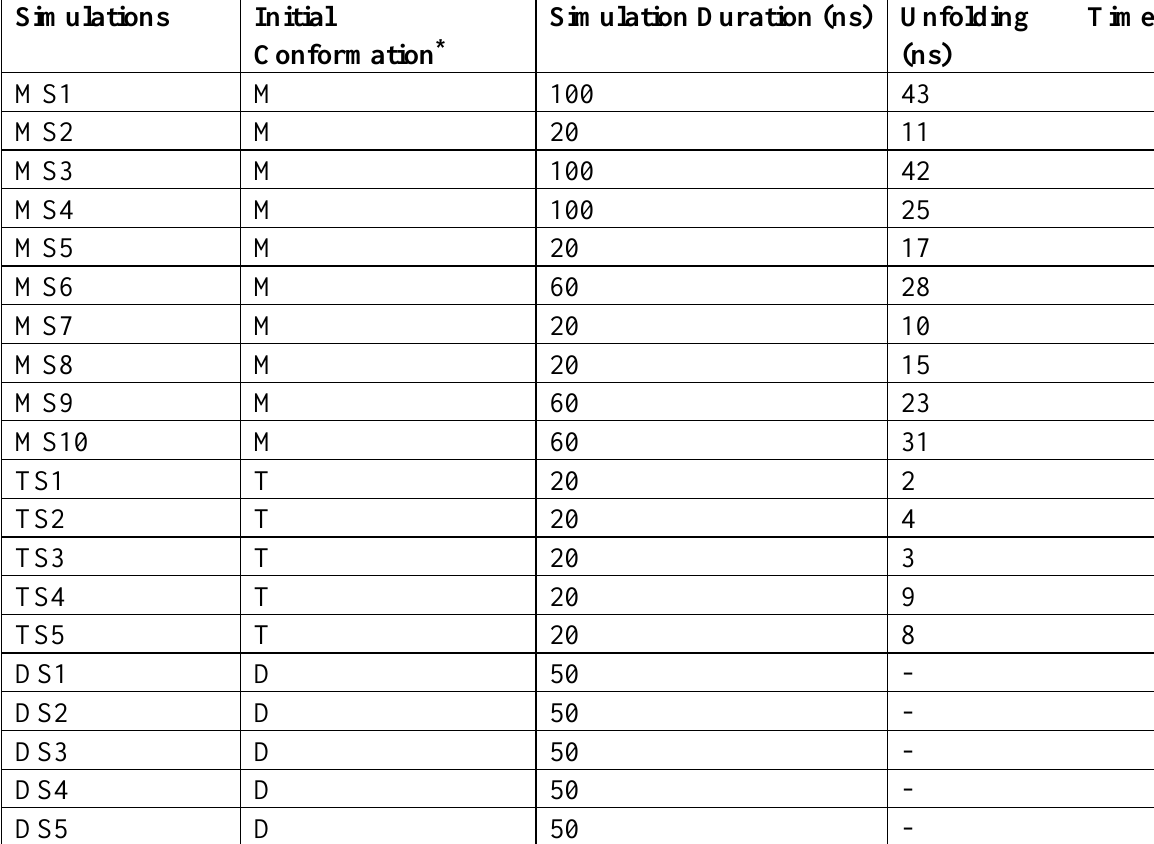
Table S1. Details of the